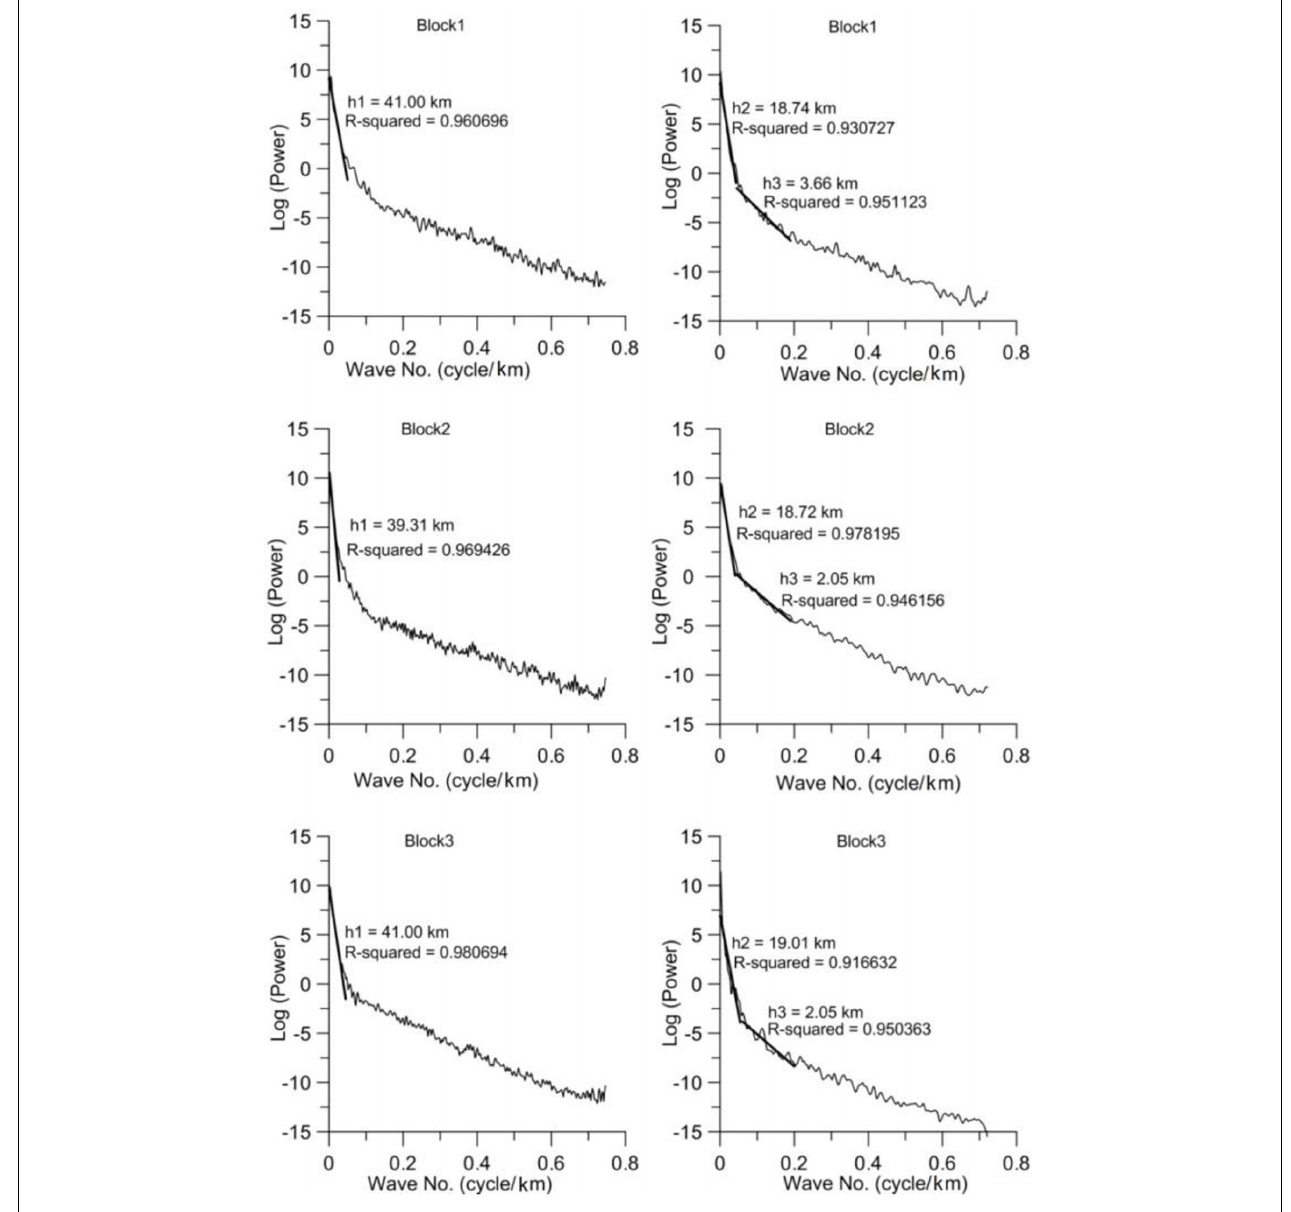
FIGURE 4 | Spectral analysis plots illustrating the estimation of interface depths at different grids. Wave number is plotted on the X -axis, and the corresponding power spectra of gravity are plotted on the Y -axis. Values of deepest density interface show Moho depth, and the shallowest interface shows sediment